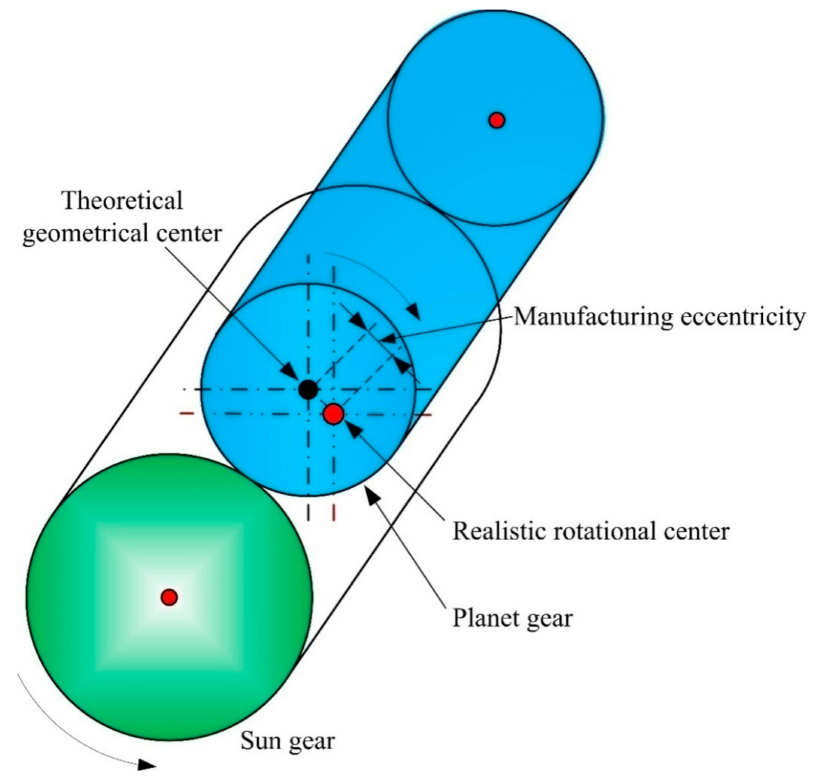
Figure 7. Definition of the planet–gear